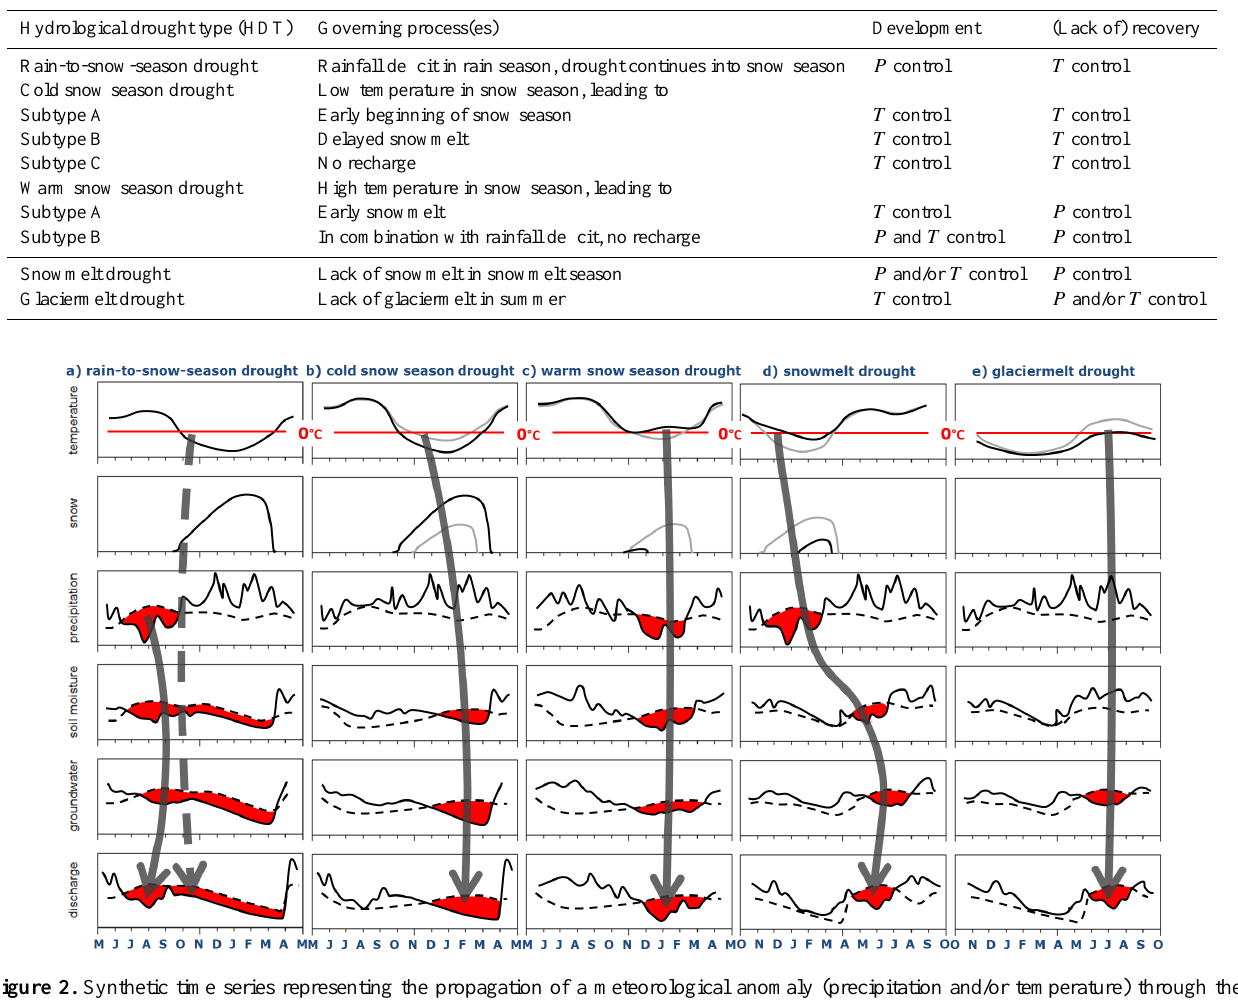
Figure 2. Synthetic time series representing the propagation of a meteorological anomaly (precipitation and/or temperature) through the terrestrial hydrological cycle per hydrological drought type (HDT) (adapted from Fig. 8.2 of Van Loon, 2013, and including new HDTs). The black lines are the time series of each hydrometeorological variable, the grey lines in the upper two rows are long-term averages of air temperature and snow, the dashed lines represent the threshold levels, and the red surfaces indicate drought events. Propagation of drought events is indicated by the arrows; dashed arrows represent a lack of recovery of the hydrological drought (meteorological drought ceased). The cold snow season drought is subtype C and the warm snow season drought is subtype B . For a description, see Table